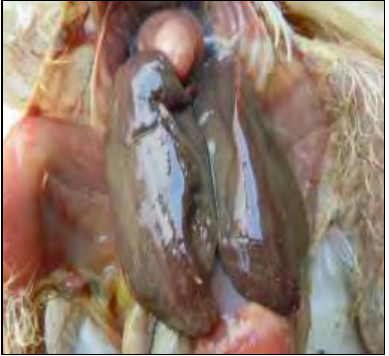
Figure-2. Bronze discoloration with enlargement of liver ( Salmonella Gallinarum infection)